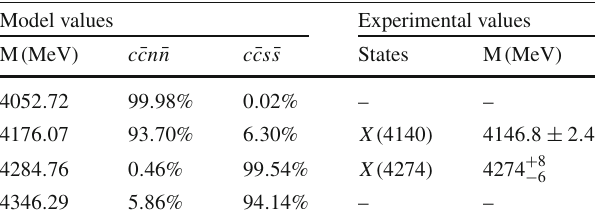
Table8 Theresultsofthe X stateswithquantumnumbers J PC = 1 ++ by considering cn ¯ c ¯ n and cs ¯ c ¯ s mixing Model